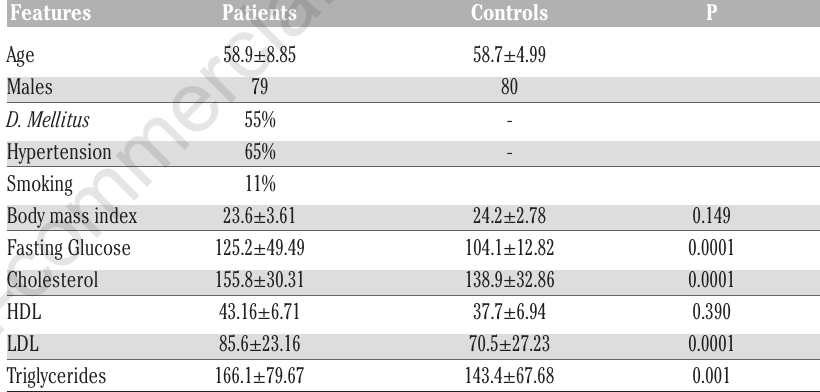
Table 1. Distribution of risk factors in patients and